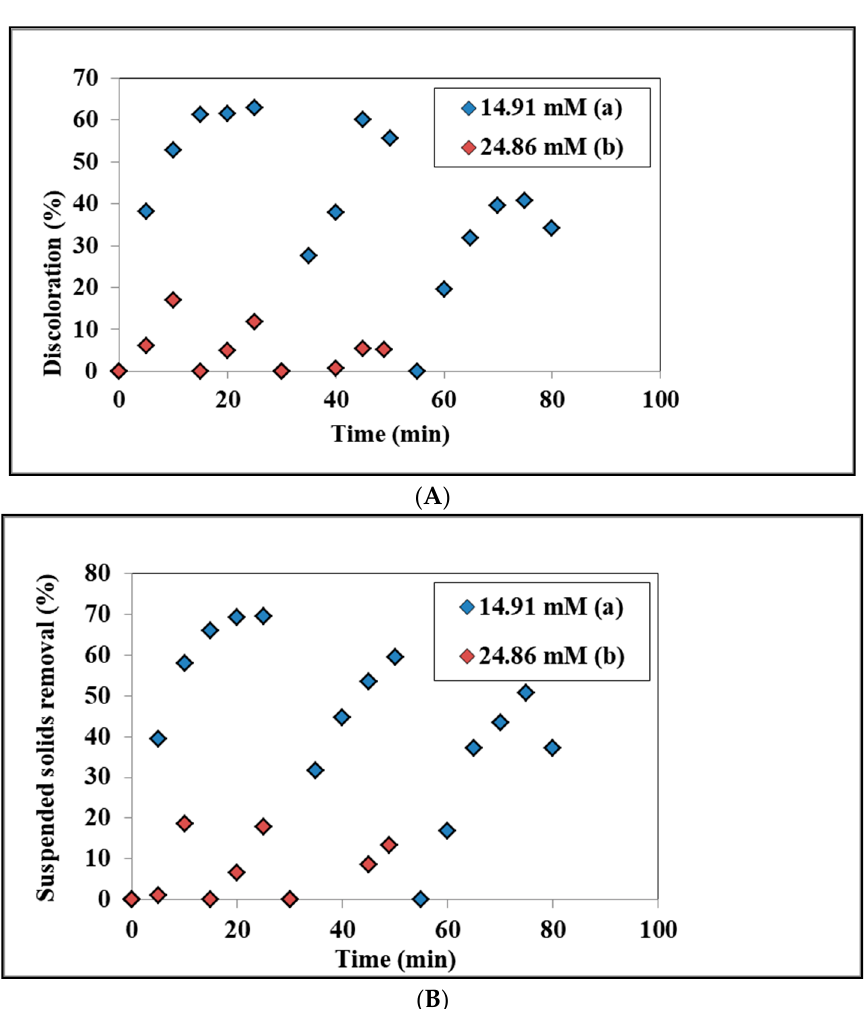
Figure 7. ( A ) Hydrogen peroxide concentration influence on discoloration (a) 17 L/h, 100 rpm; (b) 20 L/h, 200 rpm. Initial operating conditions: pH = 3.50; C 0,Fe2+ = 0.10 mM FeSO 4 . ( B ) Hydrogen peroxide concentration influence on suspended solids removal. (a) 17 L/h, 100 rpm; (b) 20 L/h, 200 rpm. Initial operating conditions: pH = 3.50; C 0,Fe2+ = 0.10 mM FeSO 4 . The overall Fenton oxidation process can be simplified as in Equation (2) [24,31].